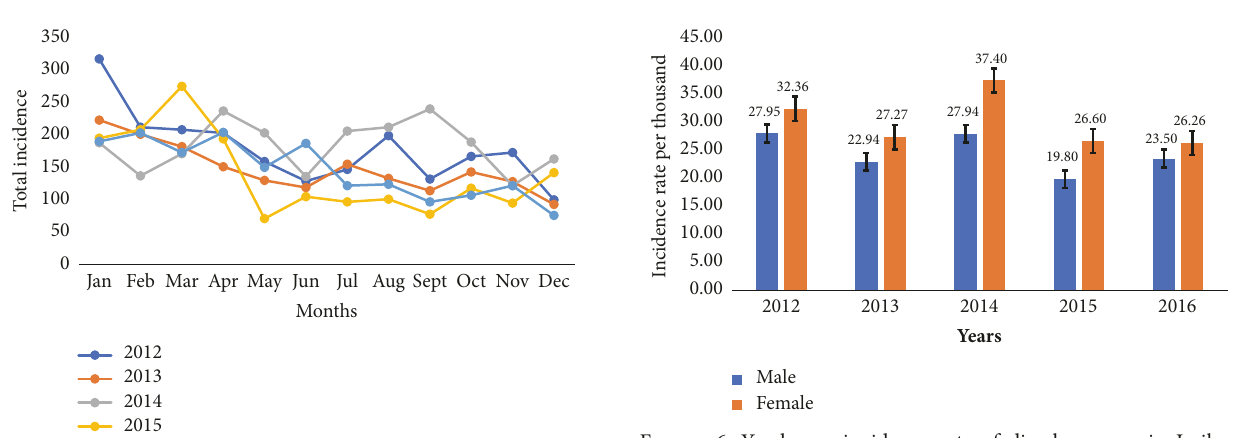
Figure 6: Yearly sex incidence rate of diarrhea cases in Jasikan District showing 95% confidence interval from 2012 to 2016.